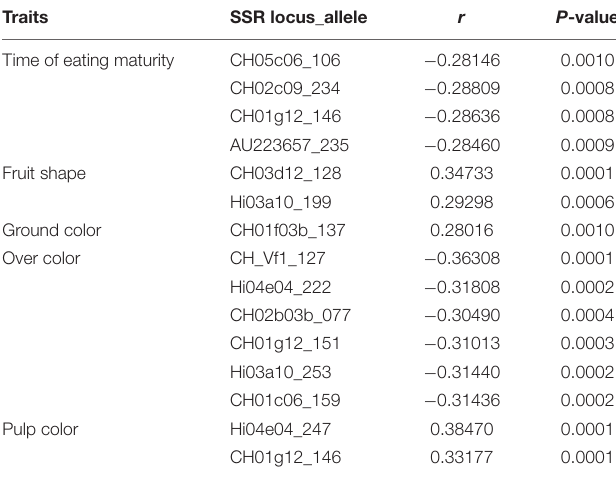
TABLE 8 | Spearman correlation coefficients ( r ) and statistical significance ( P -value) between SSRs loci and morphological